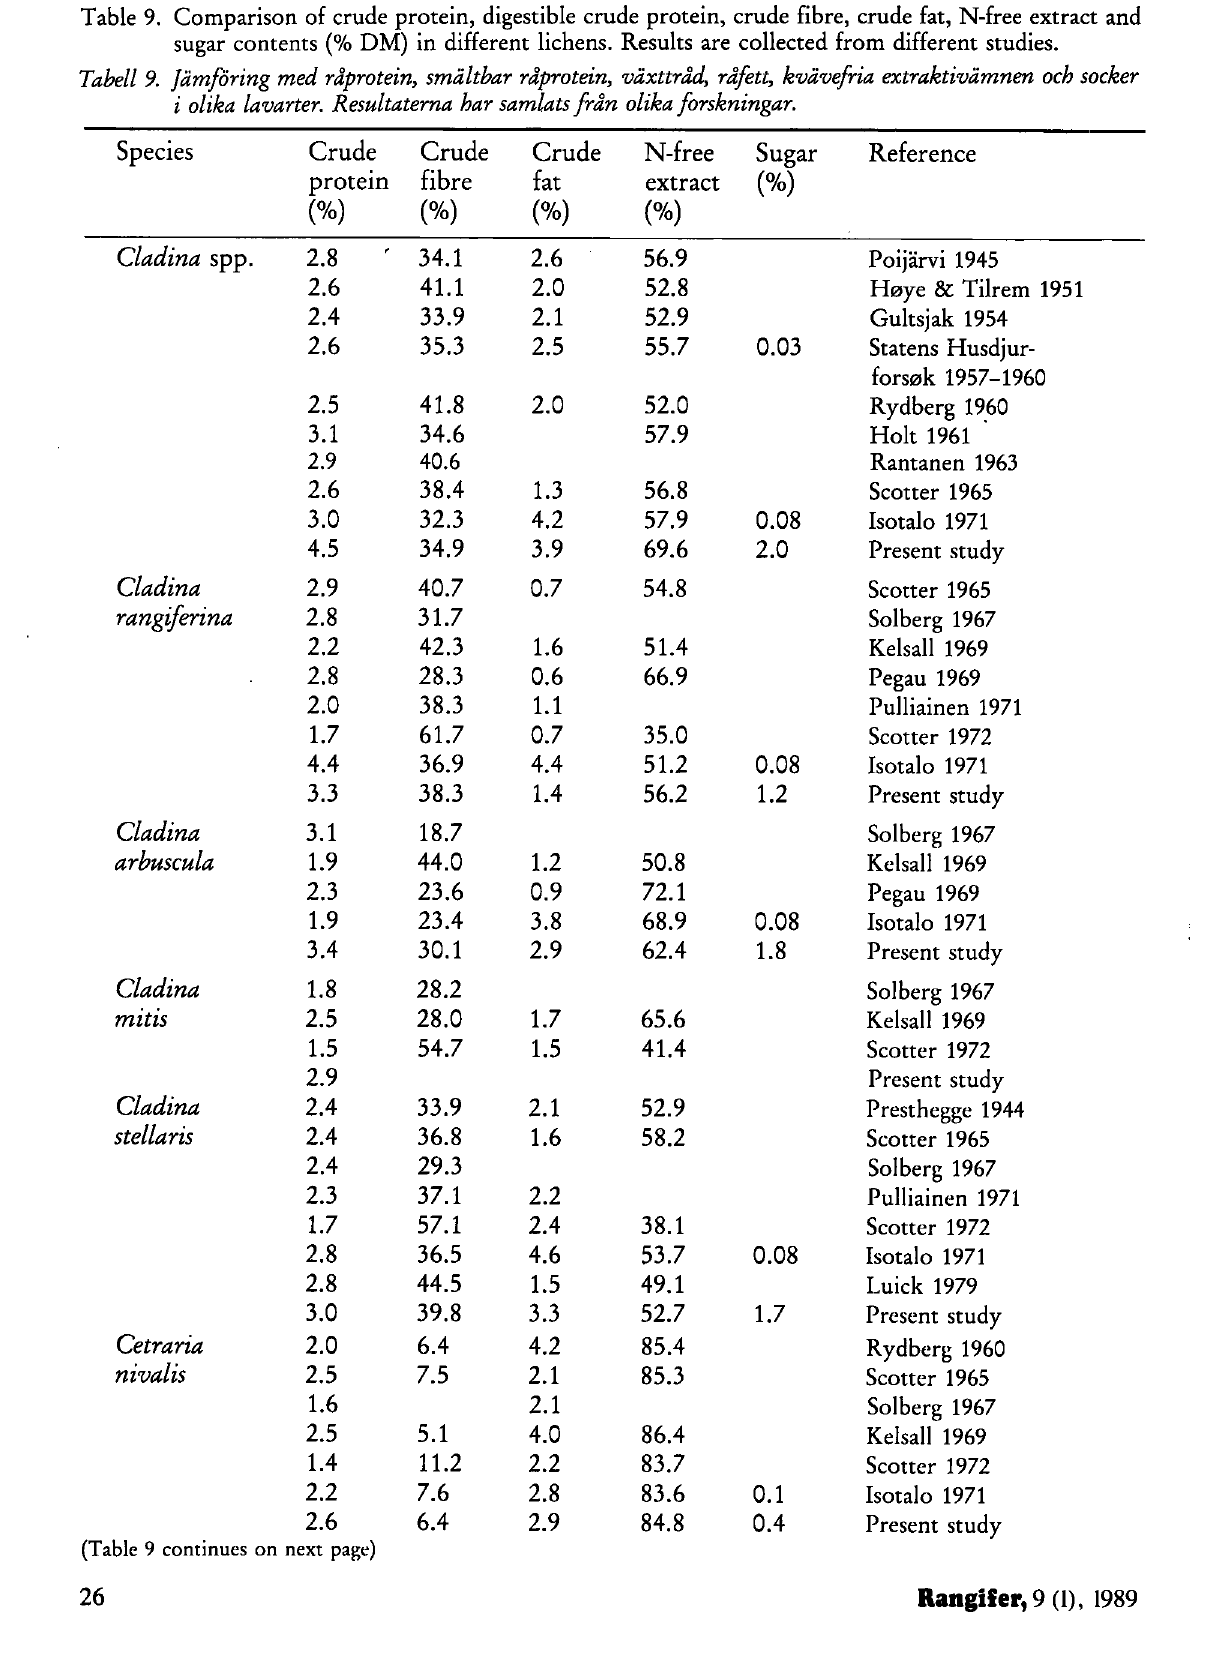
Table 9. Comparison of crude protein, digestible crude protein, crude fibre, crude fat, N-free extract and sugar contents (% DM) in different lichens. Results are collected from different